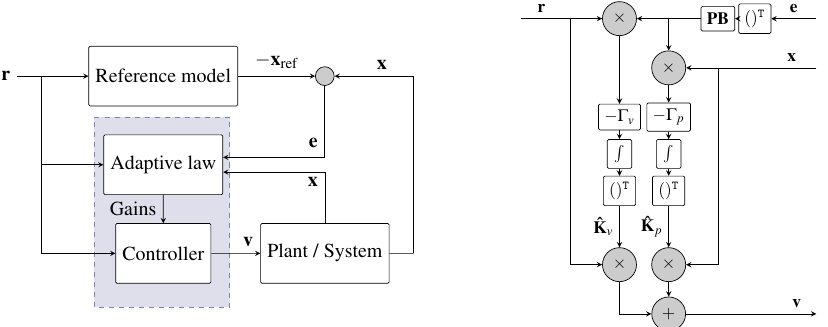
Figure 4. ( Left ): General MRAC block diagram. ( Right ): Adaptive and control law